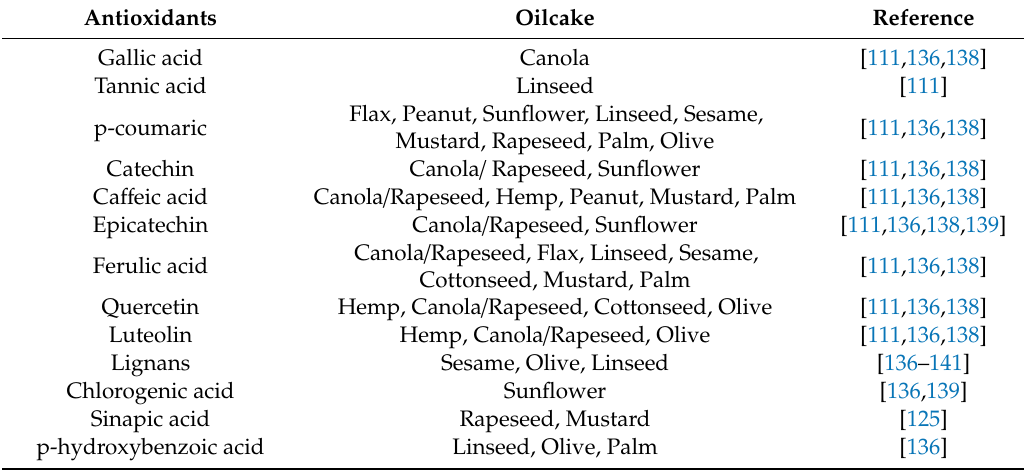
Table 3. Antioxidants in oil